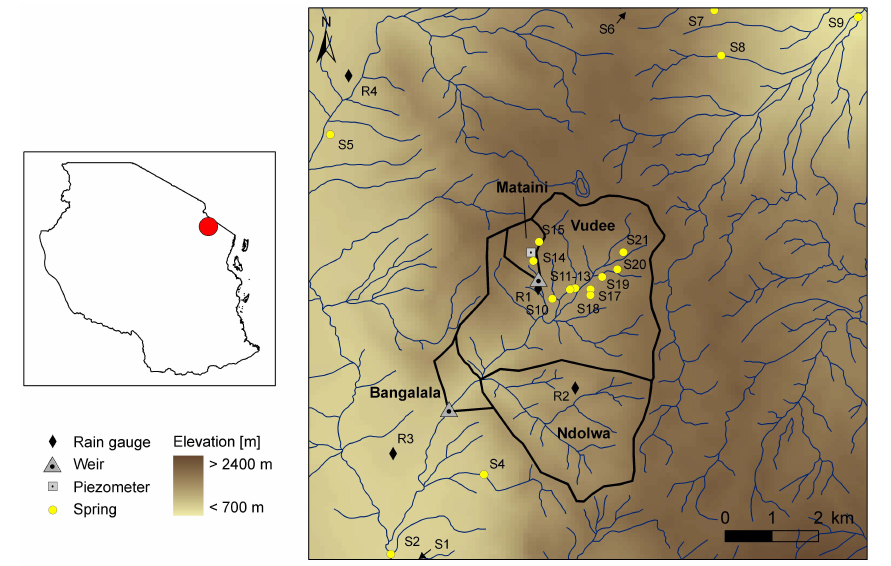
Fig. 1. Context and elevation maps of the 4 nested study catchments Mataini (0.3km 2 ) , Ndolwa (8.8km 2 ) , Vudee (14.6km 2 ) and Bangalala (25.3km 2 )